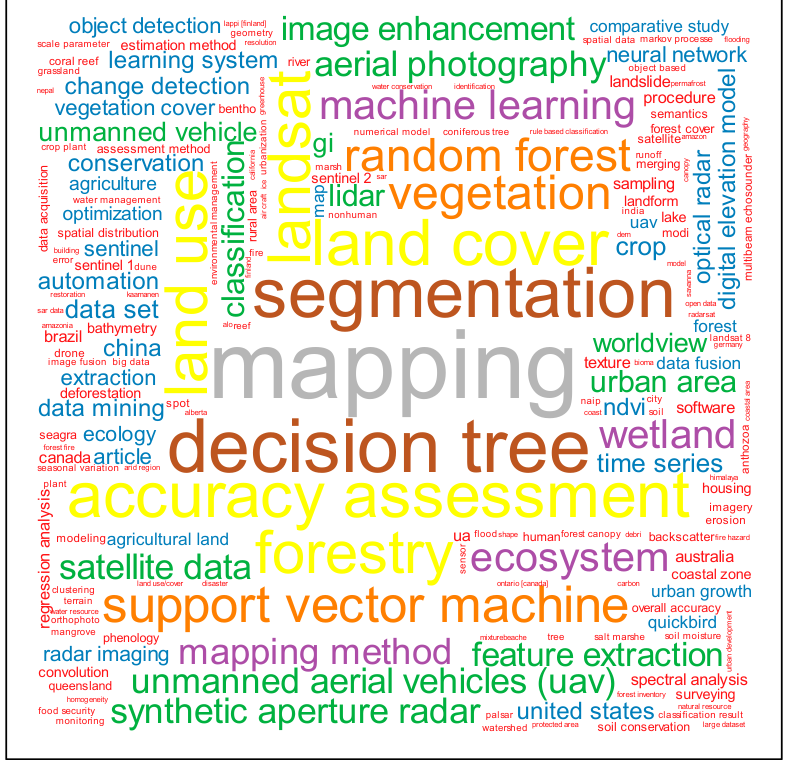
Figure 1. Wordcloud showing the frequently covered topics in geographic object-based image analysis (GEOBIA).